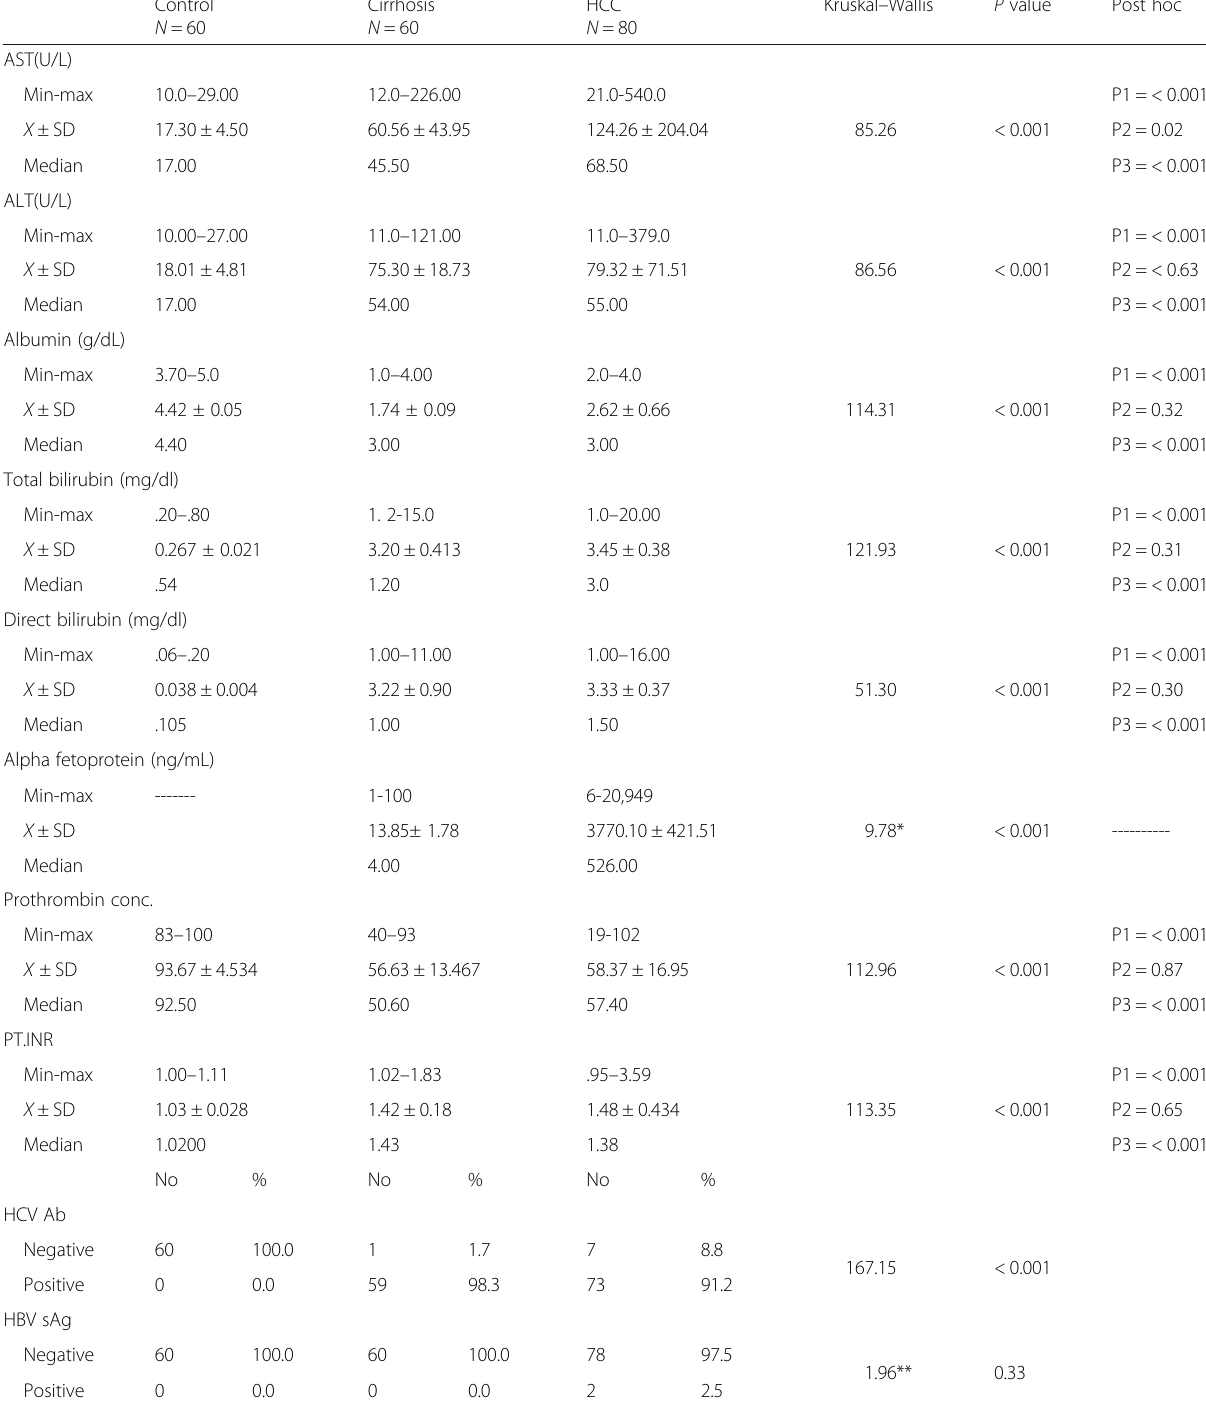
Table 2 Lab investigations of the studied